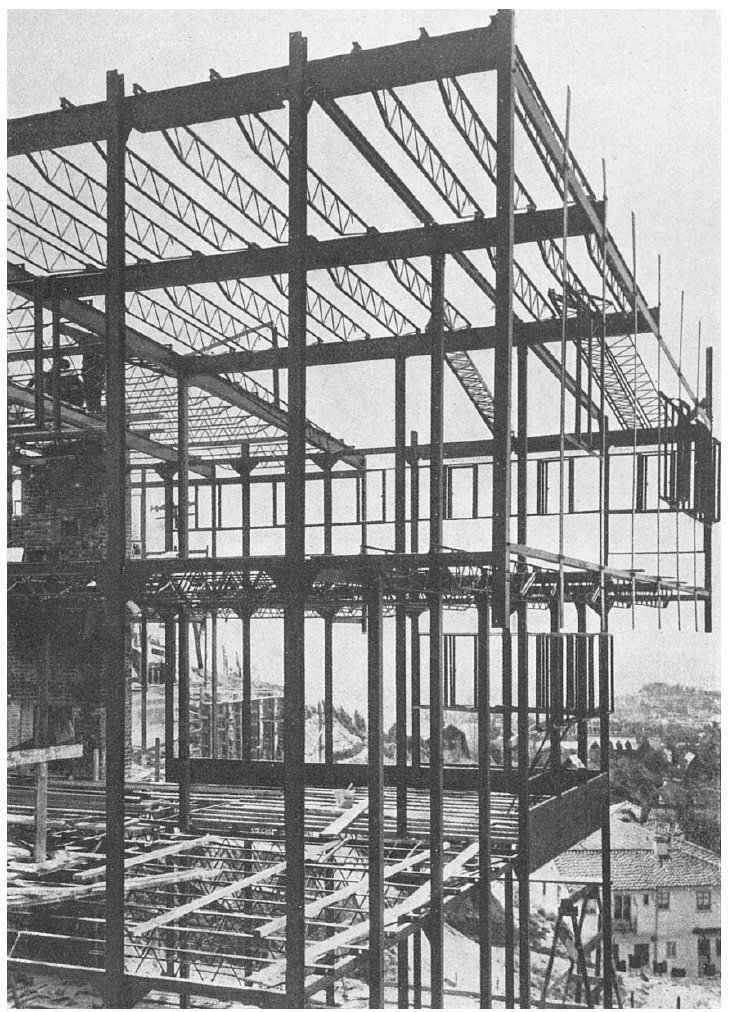
Figure 9. Richard Neutra, Lovell Health House, Los Angeles, 1927–1929. Steel skeleton. (Photo